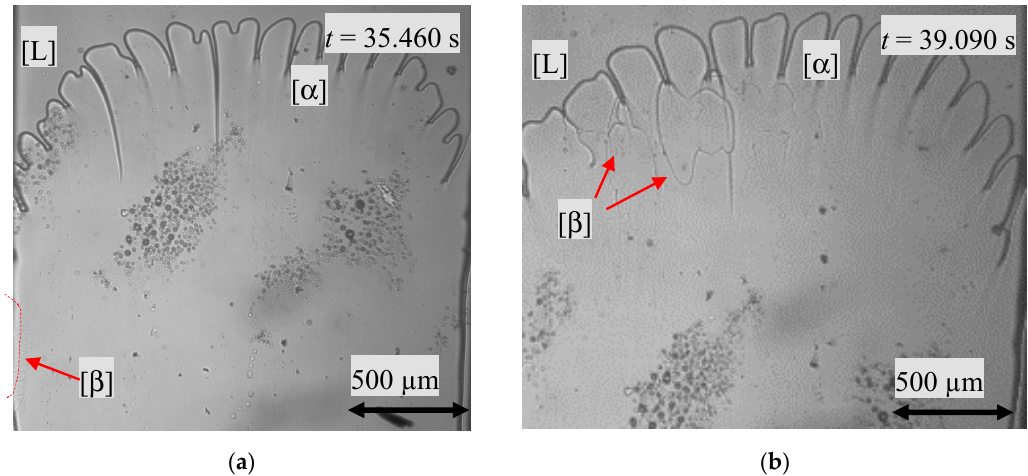
Figure 5. ( a ) nucleation event of the β -phase indicated by a red line and ( b ) dispersal of the peritectic phase along the interstitial liquid of the primary phase. The images show a width of 2.000 μ m. For a hyper-peritectic concentration of x = 0.537 (peritectic plateau: 0.47 ≤ x ≤ 0.54) and type A with G T / V p = 2.3 ∙ 10 10 K ∙ s/m 2 ( T = 1.9 · 10 − 3 K / s), the solidification morphology changed from the initial planar s/l interface via cellular growth to a dendritic solidification morphology within the first Δ t =